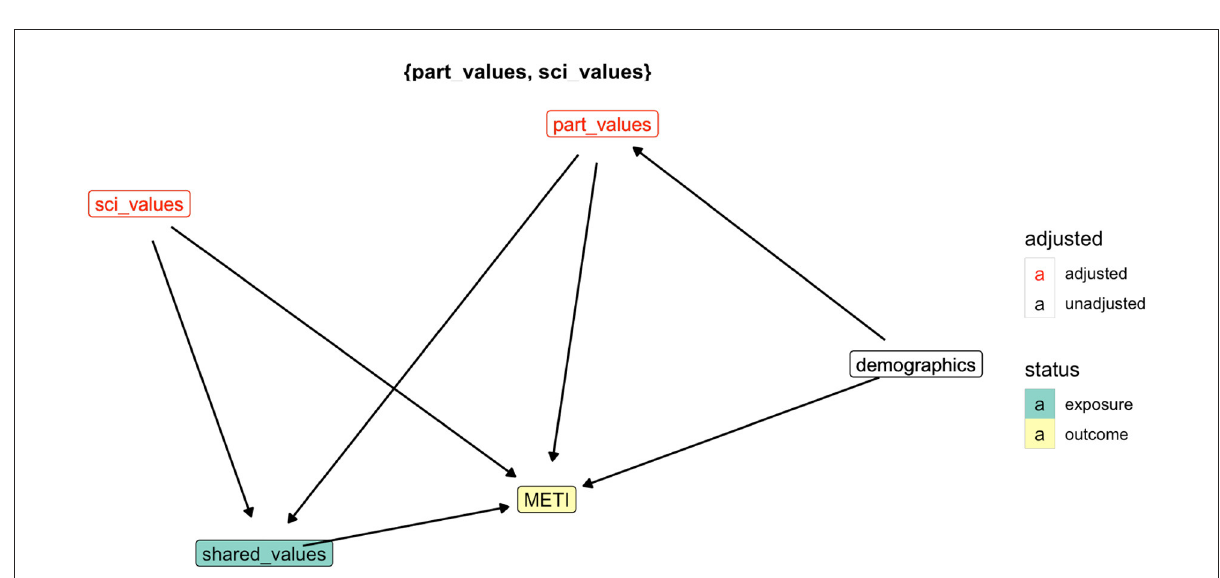
FIGURE3 Directed acyclic graph (DAG) for analysis of the shared values effect. If the DAG is faithful, adjusting for scientist values ( sci_values ) and participant values ( part_values ) is sufficient for estimating the effect of shared values on perceived trustworthiness ( METI ). In particular, adjusting for demographics should not change the regression coefficient on shared